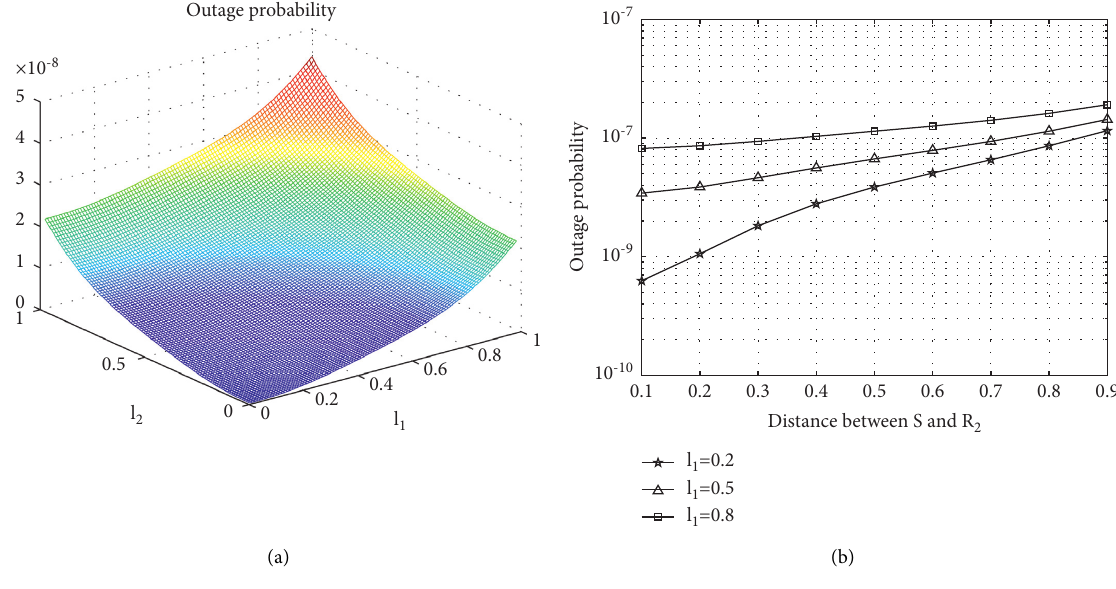
Figure 3: Outage probability against l